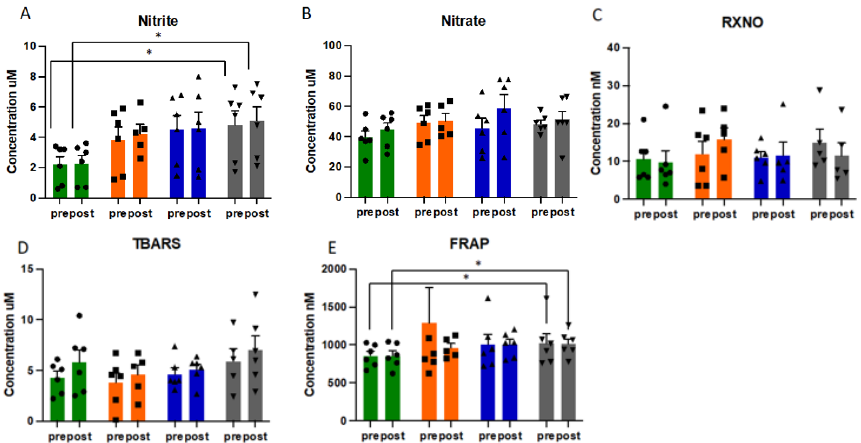
Figure 3. Pattern of redox responses to pre- and post-acute exercise challenge at each sampling point in study for plasma concentrations of nitrite ( A ), nitrate ( B ), nitroso species ( C ), TBARS ( D ) and FRAP ( E ), presented as mean and SEM, with individual data (circles, squares and triangles) overlaid. Data presented in µ M or nM. Green bars = baseline, orange bars = week 3, blue bars = week 6, grey bars = week 12. Abbreviations: CPET: cardiopulmonary exercise test; RXNO: total nitroso species; TBARS: thiobarbituric acid reactive substances; FRAP: ferric reducing ability of plasma. * = p < 0.05.